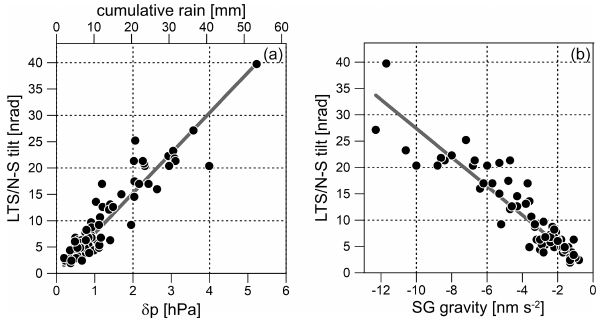
Figure 7. Short-term N–S tilt and gravity residuals (water accu- mulation phase). N–S tilt response to cumulative rain at CO (a) . Converting cumulative rain to surface pressure load reveals a tilt- to-pressure admittance of 7.6nradhPa − 1 (solid line). Relation be- tween gravity and N–S tilt residuals (b) .